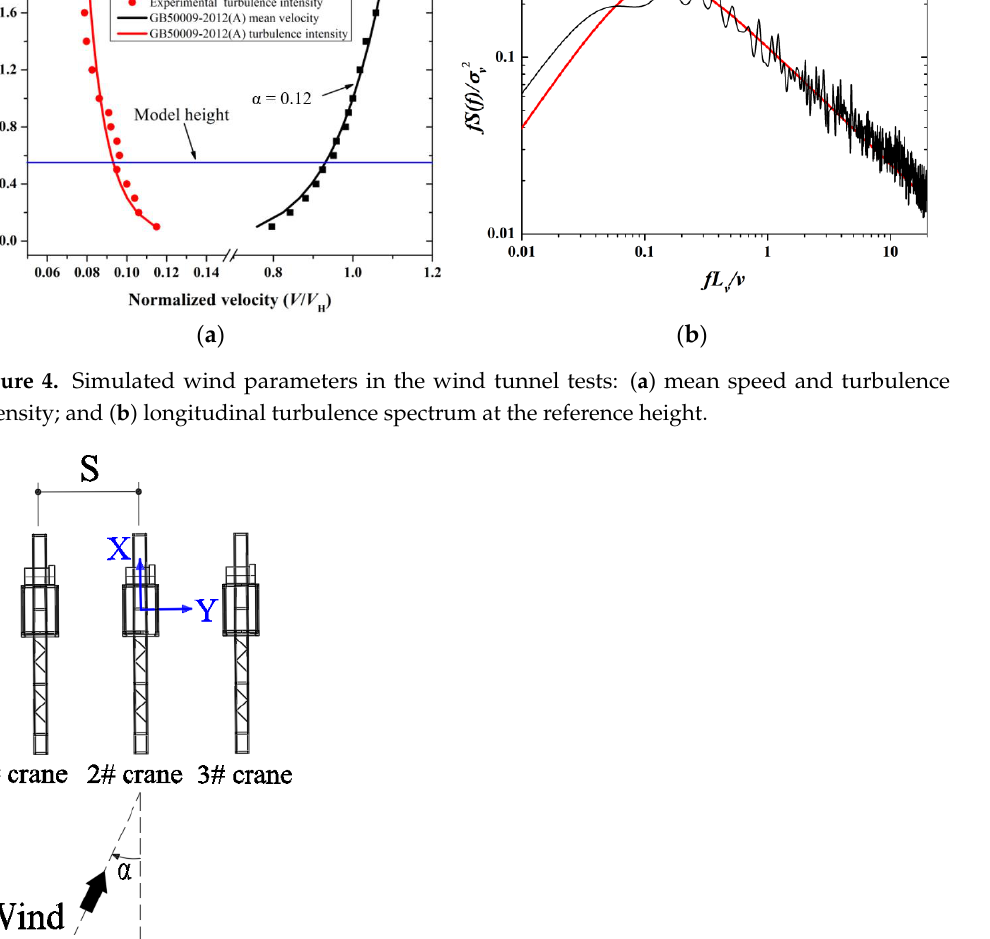
Figure 4. Simulated wind parameters in the wind tunnel tests: ( a ) mean speed and turbulence in- tensity; and ( b ) longitudinal turbulence spectrum at the reference height.